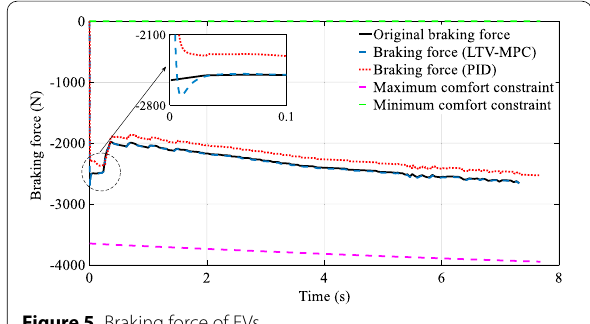
Figure 5 Braking force of EVs